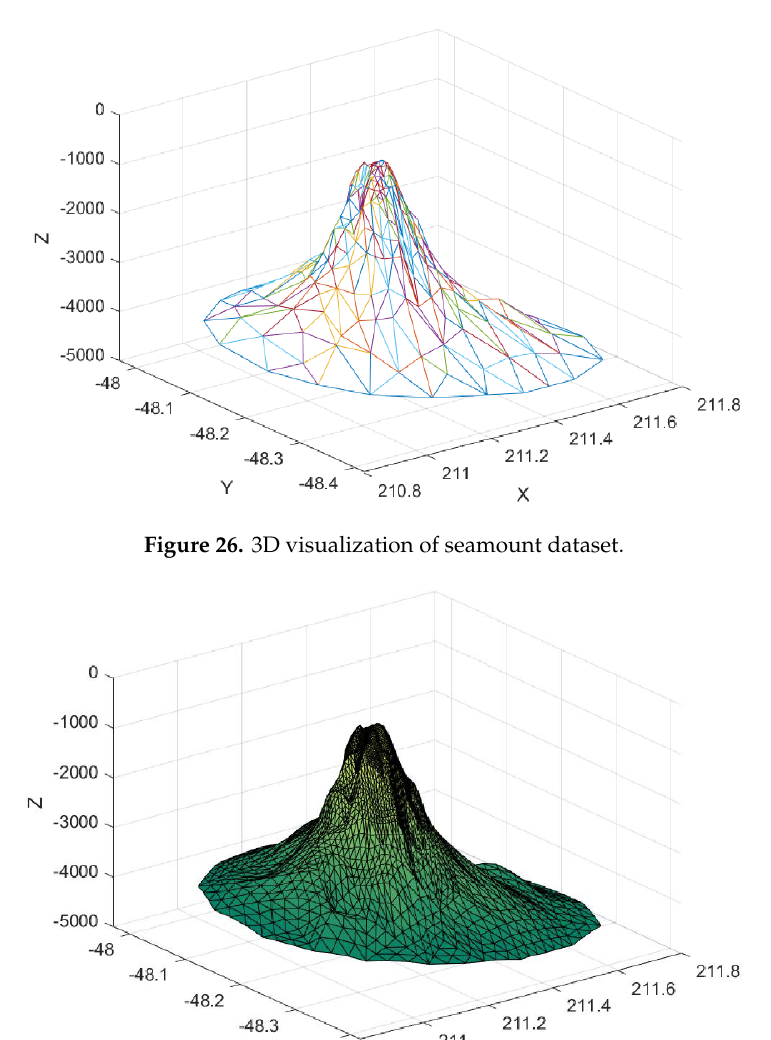
Figure 25. Delaunay triangulation of seamount dataset.